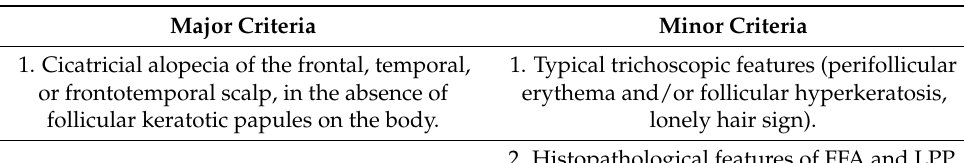
Table 4. Diagnostic criteria for